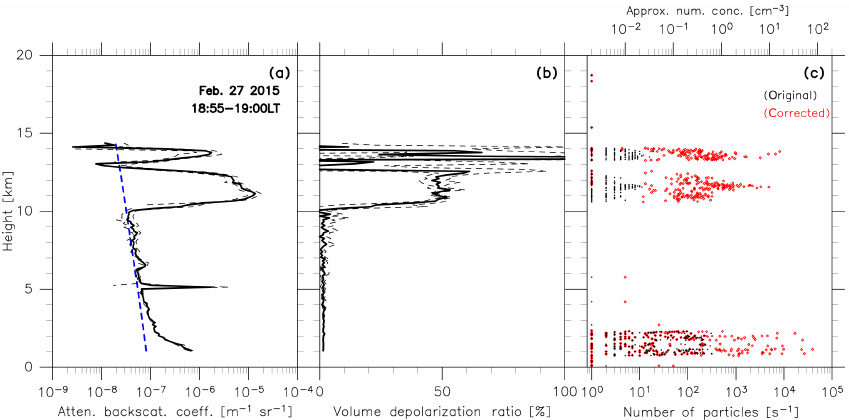
Figure 11. Vertical profiles of (a) backscattering coefficient at 1064nm (thick black) and (b) depolarization ratio at 532nm (thick black; see Shibata et al., 2012, for its definition) observed by a lidar system at Biak averaged over 18:55–19:00LT on 27 February 2015; (c) the same panel as Fig. 8b (i.e. quasi-simultaneous CPS measurements). The dashed blue curve in (a) indicates the estimated contribution of air molecules due to Rayleigh scattering. The thin dashed black curves in (a) and (b) indicate the standard deviation range. Lidar data at 0–2km and above 14km are not shown because signals were saturated for the former and data were highly noisy for the